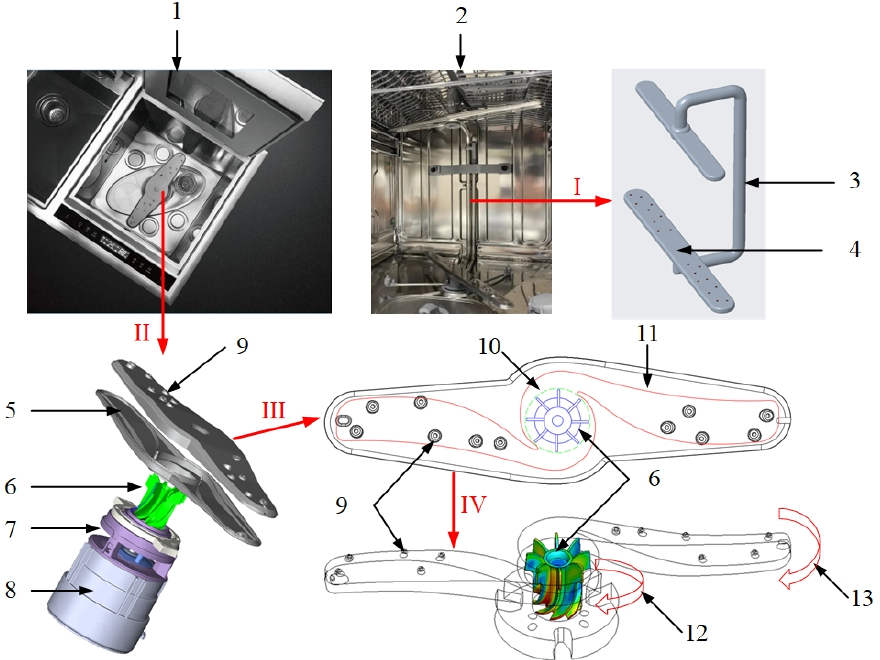
Figure 1. Comparison of the new sink-type dishwasher with innovative pump and traditional dish- washer. I: schematic diagram of spray and pipeline system of traditional dishwasher, II: a new type of